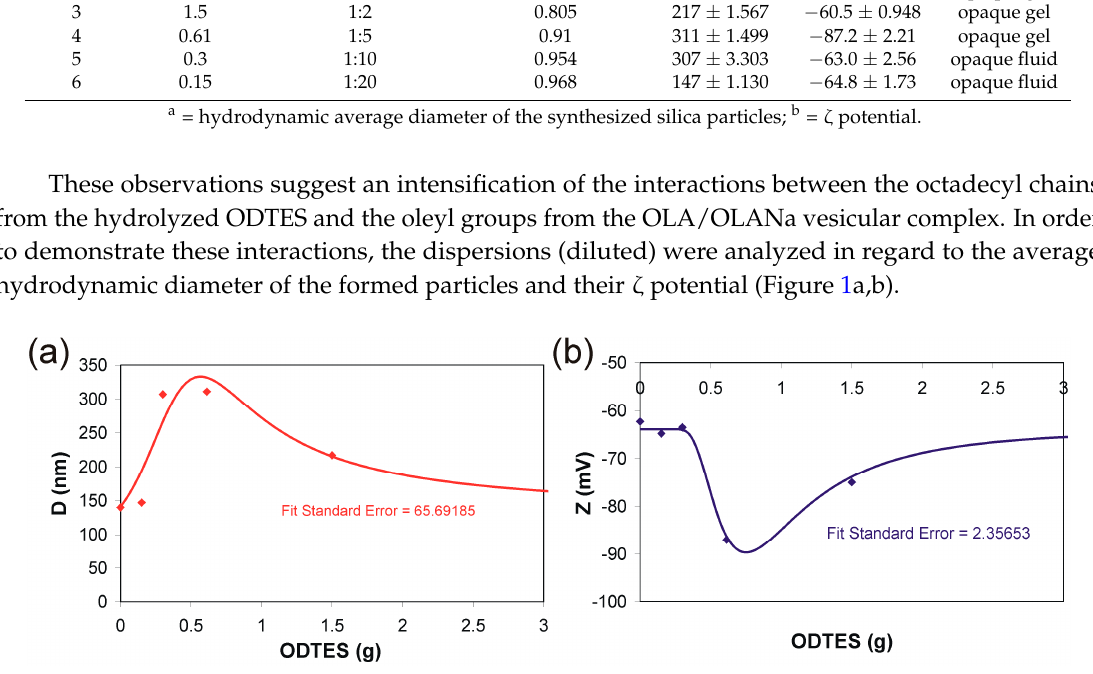
Figure 1. Evolution of ( a ) average diameter (D) and ( b ) ζ potential (Z) of the water dispersed particles, depending on the amount of octadecyltriethoxysilane (ODTES) added in the sol–gel system (The lines are for guiding the reader. The experimental data were plotted, and the given curve was fitted with Table Curve 2D version v5.01 software. The fit standard error calculated by the software is written inside each chart).